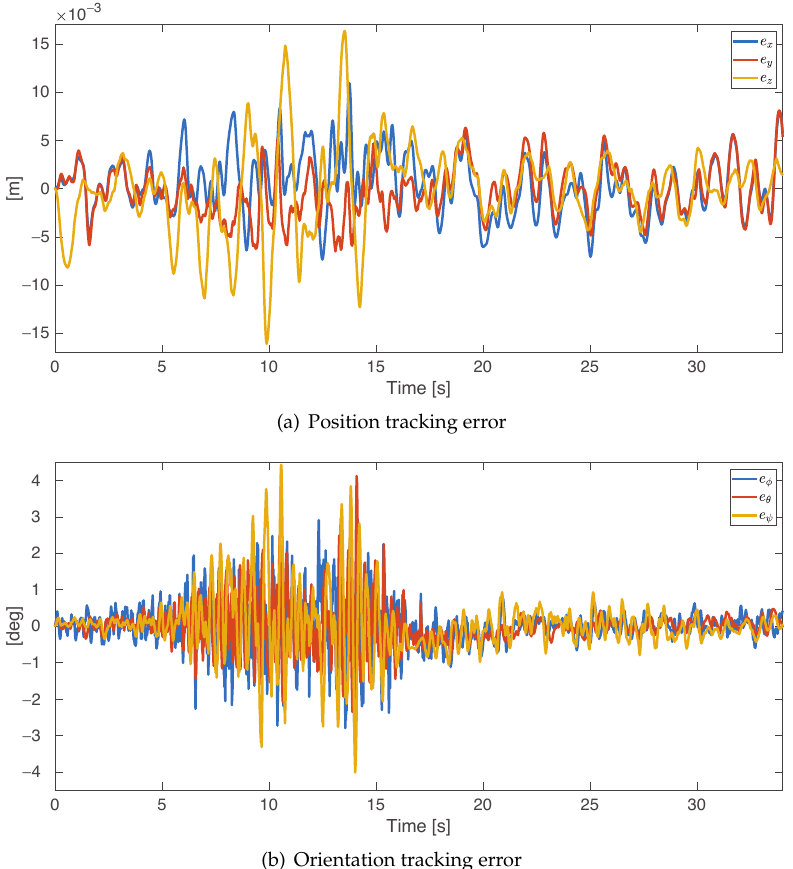
Figure 4. First case study: position and orientation tracking errors.